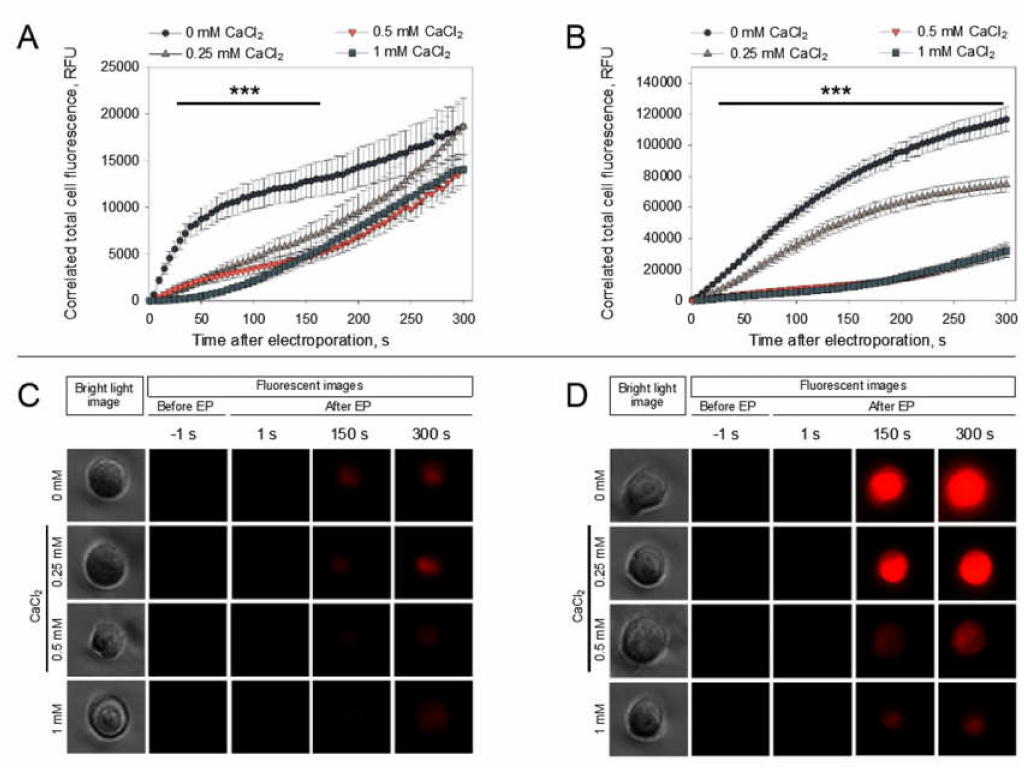
Figure 6. Visualization of PI electrotransfer into cells in media with di ff erent CaCl 2 concentrations. The cells were electroporated with single 1400 V / cm ( A ) or 1800 V / cm ( B ) strength, 100 µ s duration electric pulses. Electroporation was performed at time ‘0 s’. The fluorescent images in panels ( C ) and ( D ) represent key points images from the ( A ) and ( B ) panels, respectively. Statistical di ff erences (A and B) of PI uptake between control (0 mM CaCl 2 ) and 0.25; 0.5; 1 mM CaCl 2 are denoted by ***— p < 0.001. The error represents the mean ± standard error of mean of n = 20 experimental